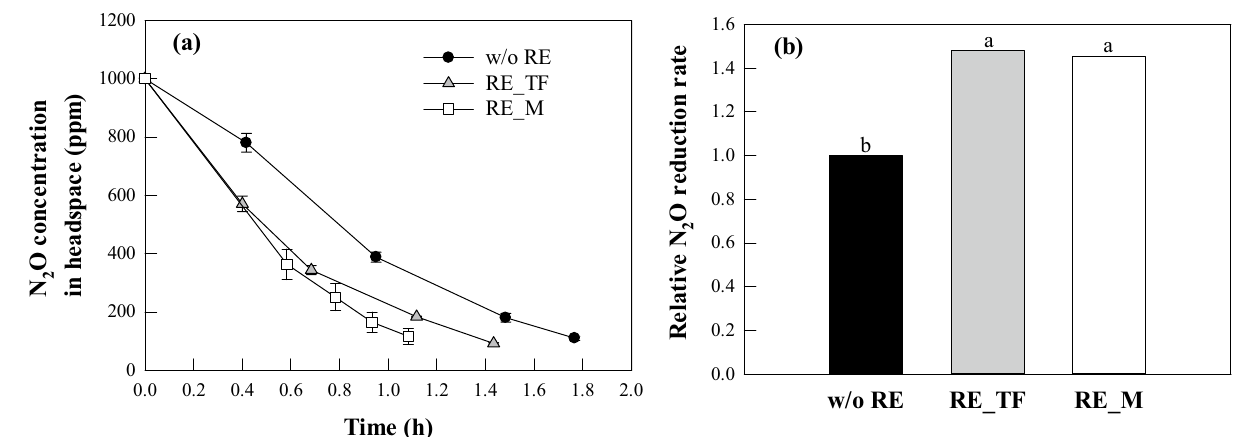
Figure 3. Effect of root exudate (RE) on N 2 O reduction by Pseudomonas sp. TF716. (a) Time profile of the N 2 O concentration in the medium with or without the RE. ( b ) Comparison of the relative N 2 O reduction rates